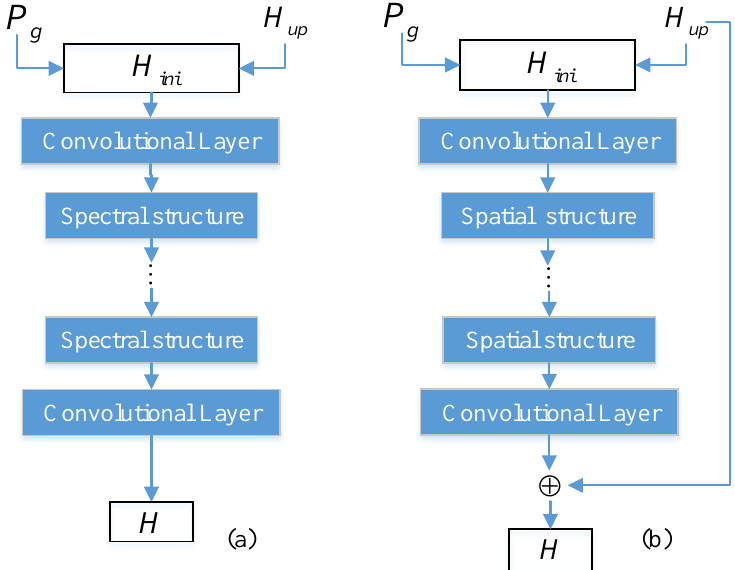
Figure 2. ( a ) The structure of the spectral network ( S 1 ), ( b ) the structure of the spatial network ( S 2 ).